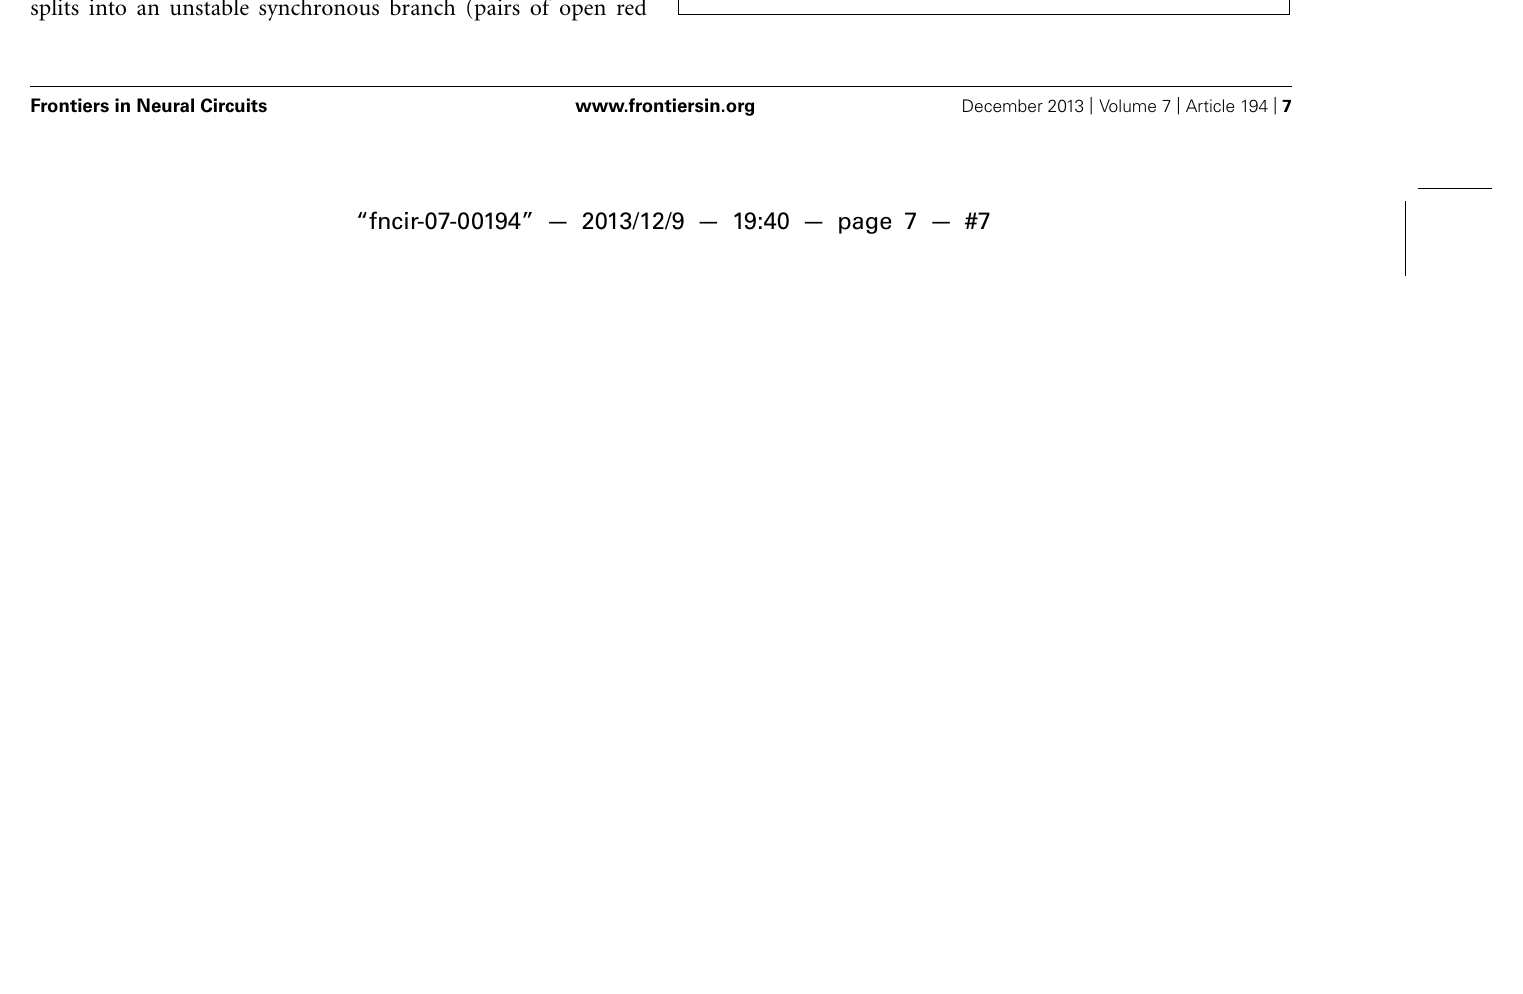
FIGURE 4 | Predicting the solution structure for pulse-coupled LIF pairs. (A) Phase response curve for a leaky integrate and fire neuron with parameters as in Figure 2 .The unstable branch is to the left of φ CL .The stable, causal limit branch of the PRC is to the right of φ CL , and neurons receiving an input on this branch fire immediately upon receipt of the input. The input phases in leader–follower mode φ L and φ F lie on the left and right branches, respectively, and must have equal phase resetting f ( φ L ) = f ( φ F ) as indicated by horizontal dotted line. Open circle denotes the average of φ L and φ F .The vertical dotted lines from (A) to (C) give the boundaries in (C) of the leader–follower mode for k = 2 and the causal limit synchrony region.The dashed line labeled y = 2 φ − 1 give the input phase for the antiphase mode φ AP with zero delay. If the center of the PRC (open circles) falls to the right of this line, the leader–follower k = 1 branch exists. (B) The PRC is replotted at half scale to show the generic relationships between the normalized stimulus interval, phase ( φ = t s/ P 0 ) and the normalized delay ( δ / P 0 ) in the leader–follower mode for k = 1 and the antiphase mode. The phase φ L at which the leader receives an input for the k = 1 leader–follower mode is twice the normalized delay ( φ L = t s L / P 0 ; t s L = 2 δ , see Figure 3B , so φ L = 2 δ / P 0 ).The follower receives an input at phase φ F and fires immediately.This leader–follower mode ceases to exist when twice the normalized delay value reaches φ CL ; beyond that point, the antiphase mode gains stability. In this antiphase mode, both neurons receive an input at the same phase (see Figure 3C ) on the right stable branch indicated in (B) , and fire immediately upon receiving the input. On this branch, the normalized stimulus interval for each neuron is equal to twice the normalized delay. (C) Predicted solution structure as delays are varied for two neurons coupled via the PRC in (B1) .The two time lags